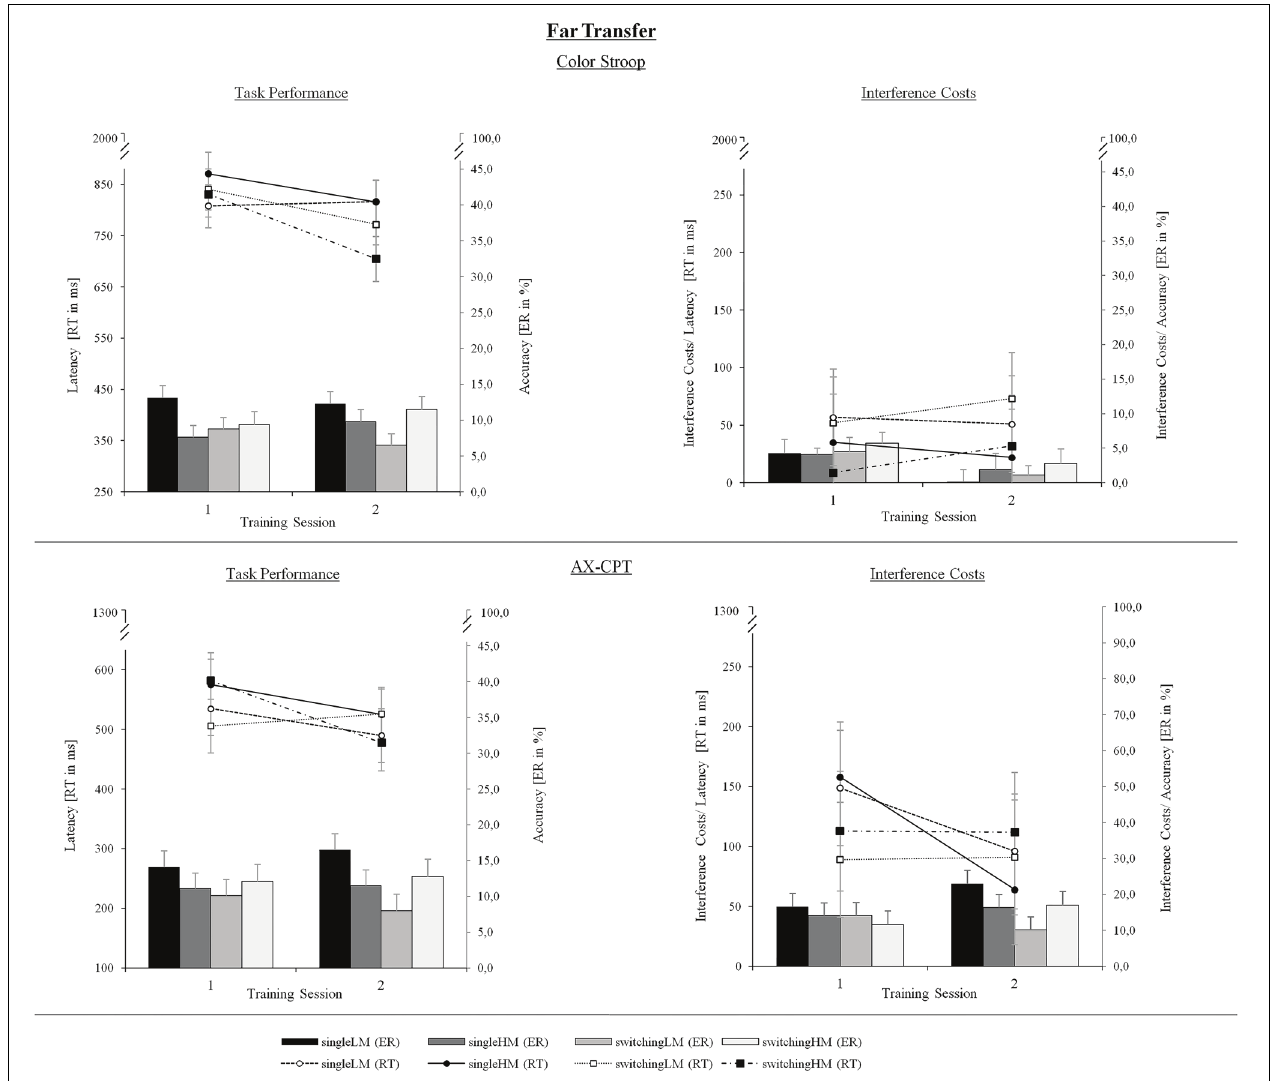
FIGURE 8 | Far-transfer performance on inhibitory control: mean latencies (ms) and error rates (%) (upper left panel) as well as respective interference costs (upper right panel) of the Stroop task; mean latencies (ms) and error rates (%) (lower left panel) as well as respective interference costs (lower right panel) of the AX-CPT, as a function of